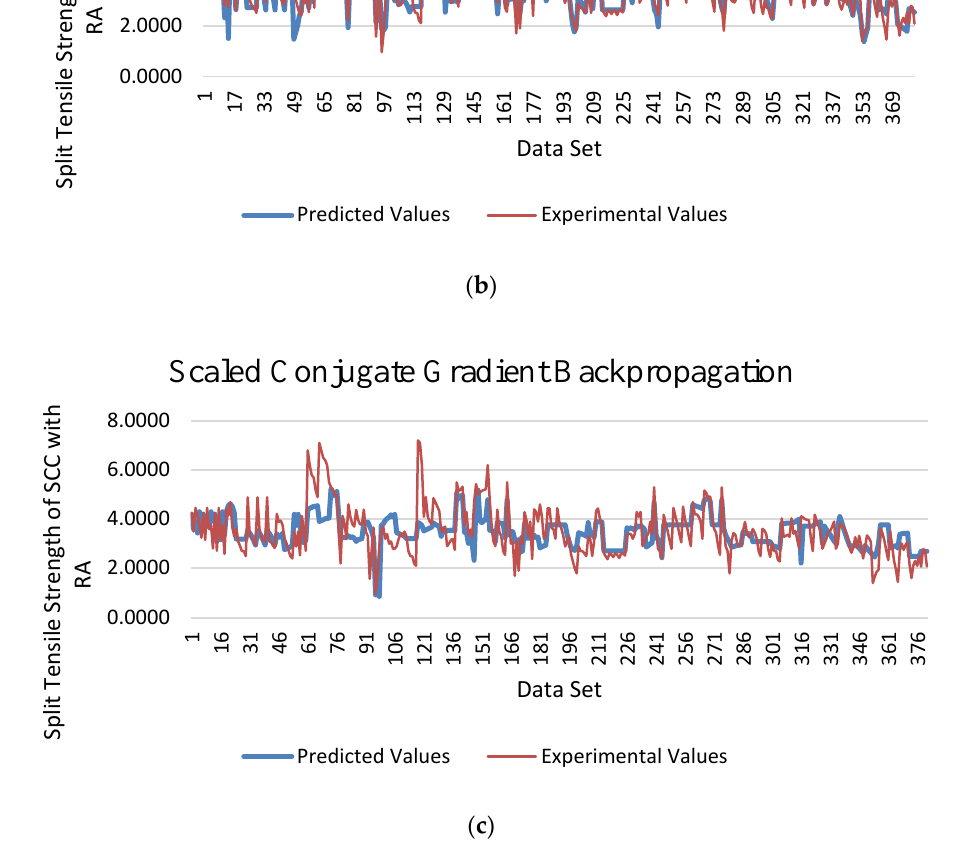
Figure 16. R-value and MSE of LM, BR, and SCGB algorithms.